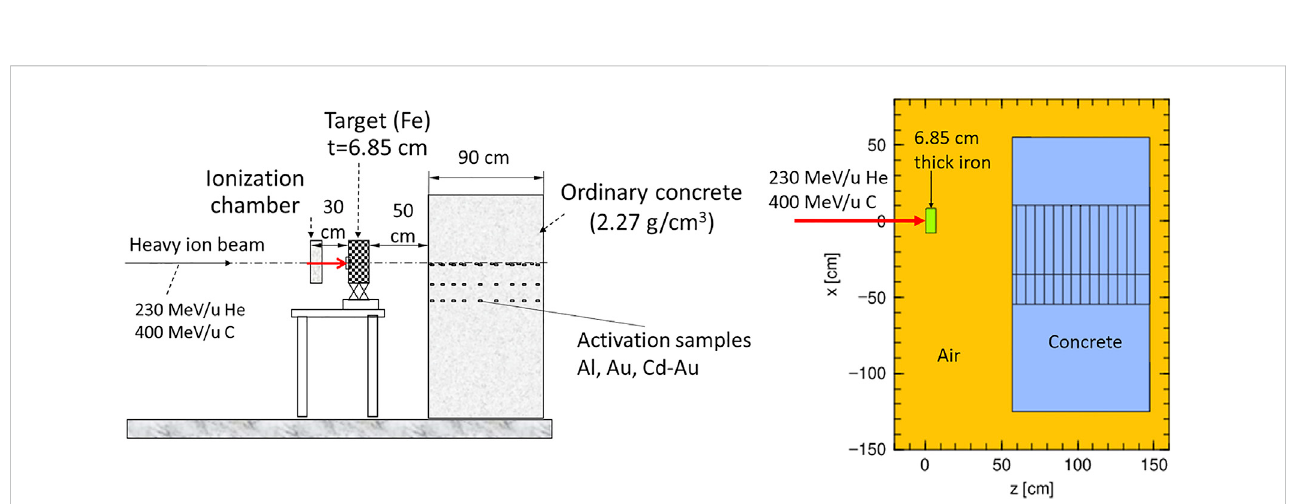
FIGURE 5 The experimental layout used in HIMAC and geometry in PHITS calculations. Heavy ion beam was incident on the iron target and secondary particles producedby nuclearreactions wereinjected into theconcrete shield. The activation samplesweresetinparallel orlines alongto thebeamaxis